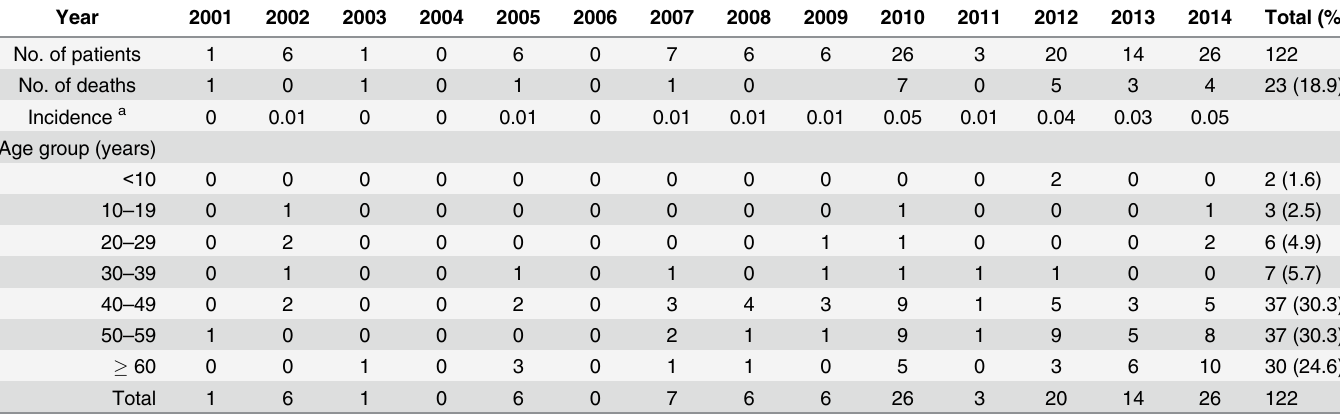
Table 1. Age distribution among patients with Japanese encephalitis in South Korea between 2001 and